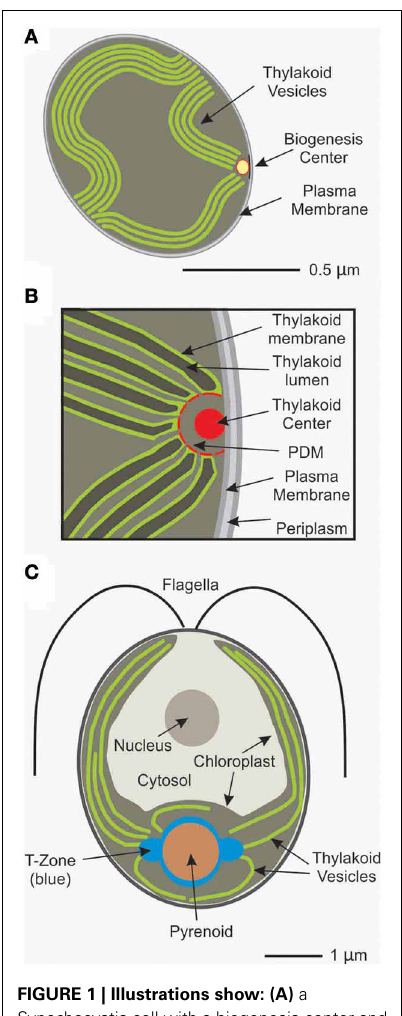
FIGURE 1 | Illustrations show: (A) a Synechocystis cell with a biogenesis center and other relevant compartments; (B) a higher magnification view of a biogenesis center formed by the central thylakoid center and the surrounding PDMs; and (C) a Chlamydomonas cell with the T-zone and other intracellular